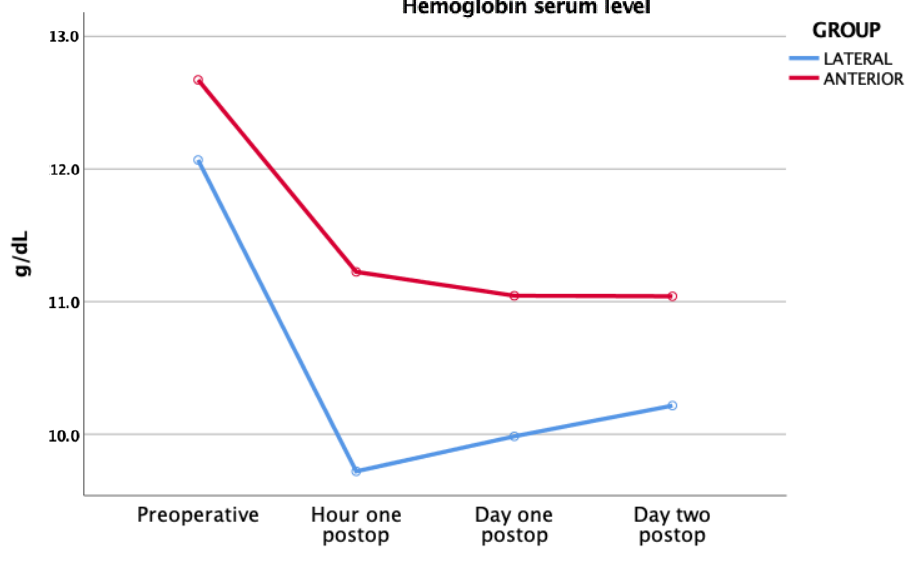
Figure 1. Hemoglobin serum levels within each group. Most of the common comorbidities recorded were: 38 (76%) hypertension; 31 (62%) diabetes mellitus type II; 29 (58%) hypercholesterolemia; 17 (34%) gastroesophageal reflux disease; 14 (28%) hypothyroidism; 10 (20%) chronic obstructive pulmonary disease; 9 (18%) atrial fibrillation; 9 (18%) chronic kidney disease; 8 (16%) dementia; 3 (6%) inflam- matory bowel disease; 11 (22%) with a history of neoplasia (4 rectum, 3 lung, 2 mammary, 1 kidney, 1 liver); 2 rheumatoid arthritis (4%) and 1 multiple sclerosis (2%). A total of 13 patients (26%) showed ≥4 comorbidities. The Nottingham Hip Score frequencies were: 3 points in 2 cases (4%); 4 points in 13 patients (26%); 5 in 22 (44%); 6 in 9 (18%); 7 in 3 (6%) and 8 points in 1 patient (2%). The patients were classified according to ASA score: 15 patients were ASA 2 (30%), 8 patients in group A and 7 patients in group B; 28 patients were ASA 3 (56%), 13 in group A and 15 in group B; and 7 were ASA 4 (14%), 4 cases in group A and 3 in group B.